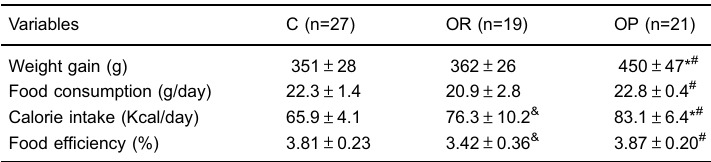
Table 1. Nutritional characteristics during protocol of obesity induction and maintenance after 20 weeks of treatment. Variables